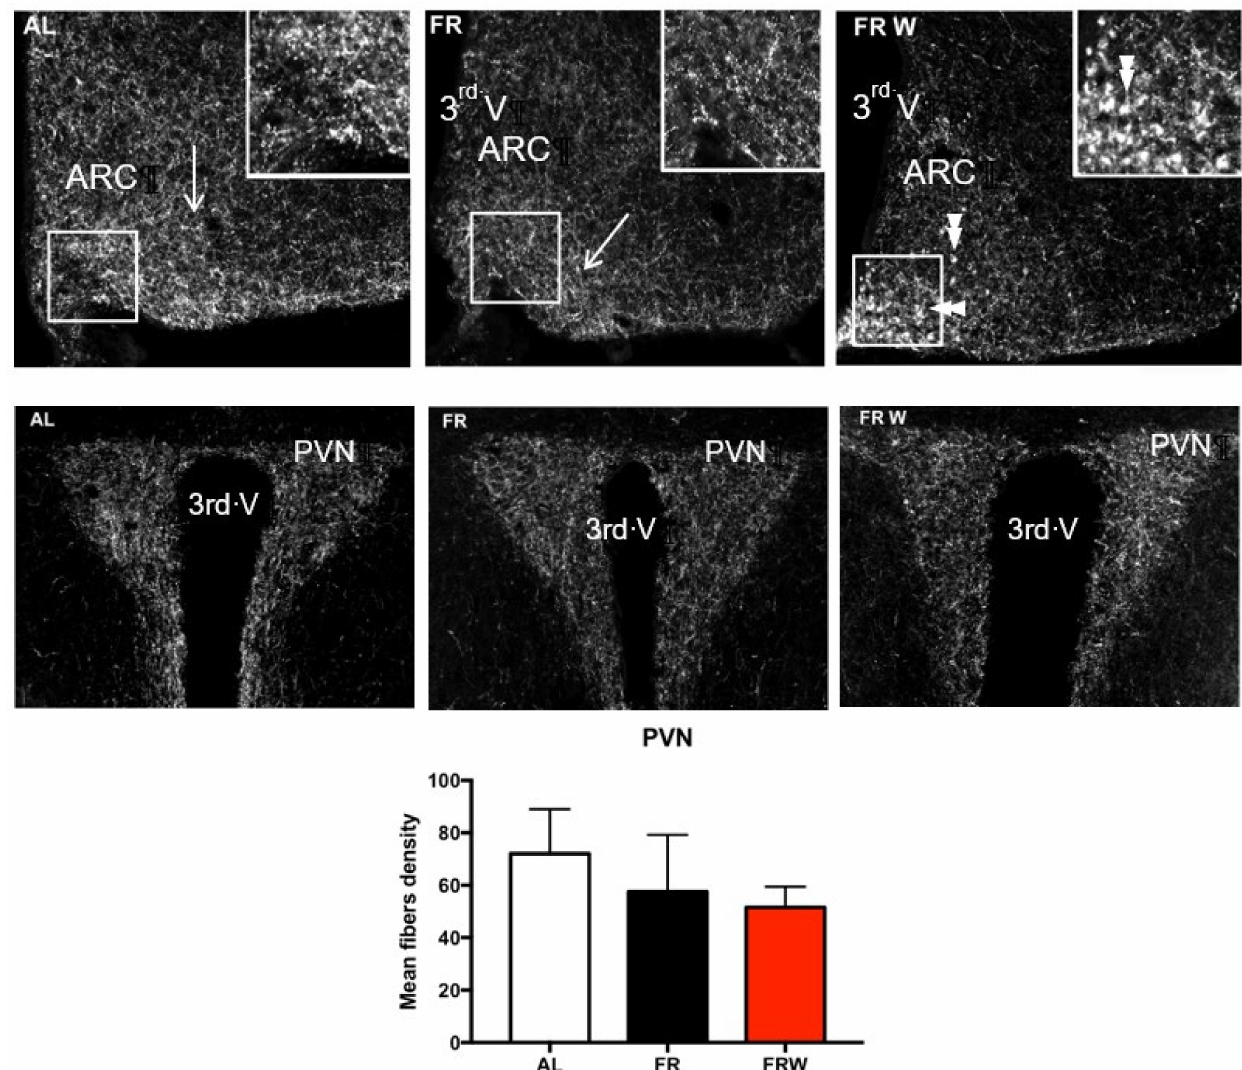
Figure 4. Immunohistochemical detection of AgRP (agouti-related peptide) in hypothalamic arcuate nucleus (ARC), fibers (arrows) and cell bodies (double arrows) and paraventricular nucleus (PVN) in AL, FR and FRW groups submitted to a short-term protocol. The three groups did not show any significant changes in the AgRP fibers density in the PVN. AL: ad libitum ; FR: food restricted; FRW: food restricted with wheel; 3rd V: 3rd